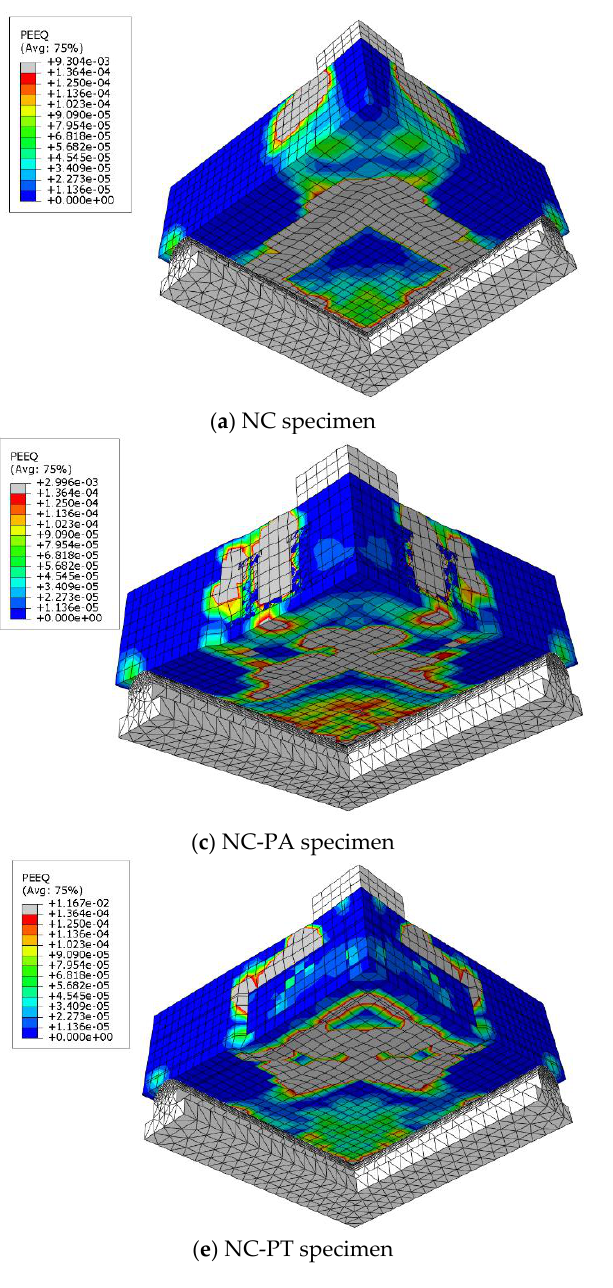
Figure 21. Analytical NC specimens